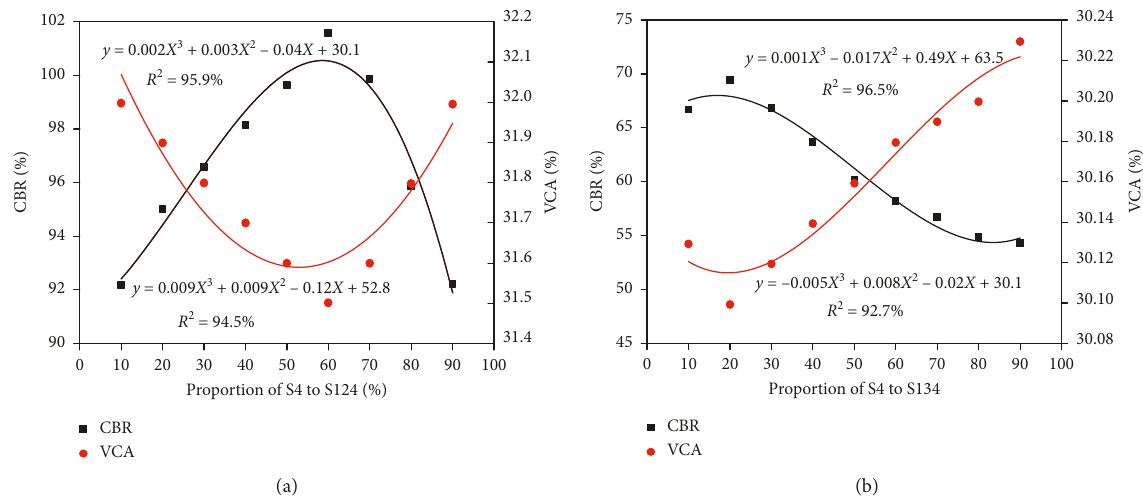
Figure 10: CBR and VCA of two kinds of three-aggregate mixtures with gap gradation (a) S124 and (b)